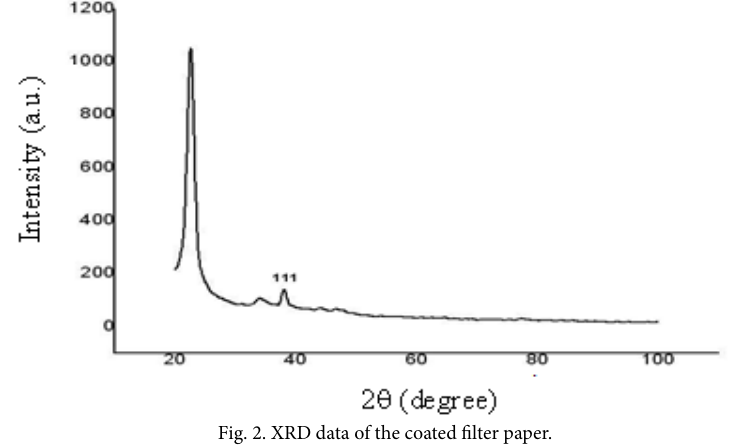
Fig. 2. XRD data of the coated filter paper.